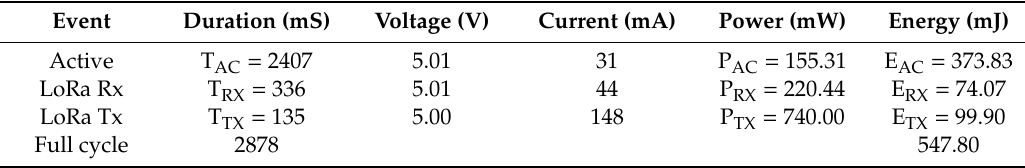
Table 5. Event-wise energy calculation of the SN with a 3-sec cycle using the LDAP.